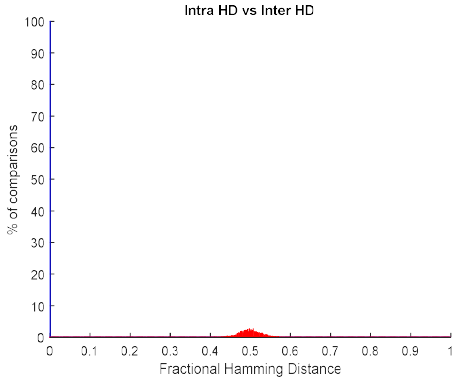
Figure 6. Fractional Hamming Distances between the correct secret key and the secret keys reconstructed by genuine cameras (on the left) and by impostor cameras (on the right). Table 1. Comparison with other proposals using hardware-based PUFs.